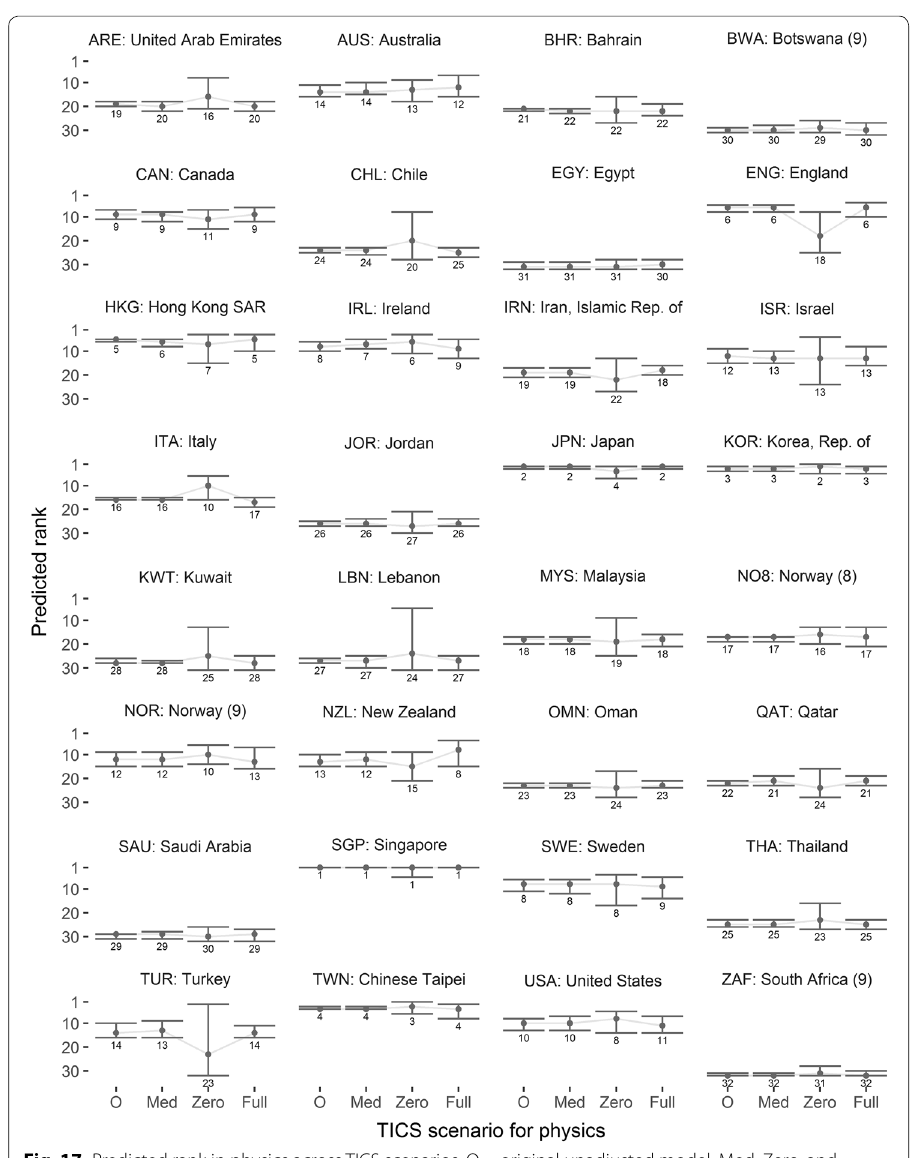
Fig. 17 Predicted rank in physics across TICS scenarios. O Full all schools have implemented the country-specific median, the least possible, or most possible level = of TICS within the country, respectively. A blue confidence interval with a downward arrow indicates a significantly lower rank than the original scenario (e.g. Qatar for zero TICS scenario in